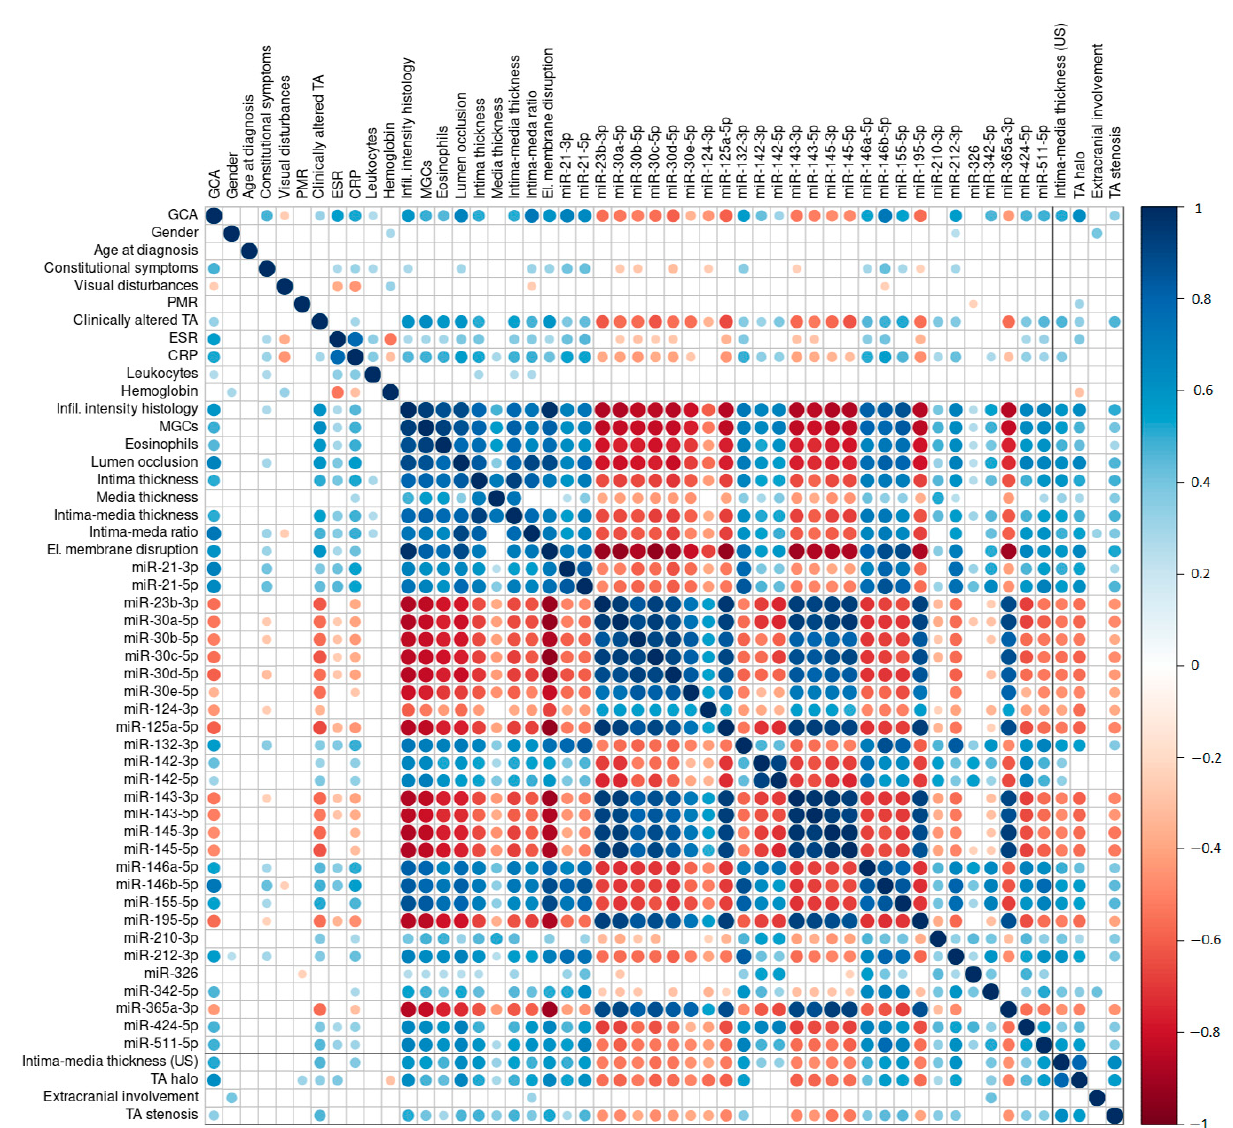
Figure 2. Correlation matrix of associations between all diagnostic parameters included in the study. Associations were calculated based on variable type combinations (nominal vs. nominal— ϕ ; nominal vs. numeric— r ; numeric vs. numeric— ρ ). Blank squares represent non-significant associations. The direction and level of corresponding correlation coefficients are presented with colors (blue for positive correlation; red for negative correlation) and their respective intensities with circle size (size of the circle increases proportionally to the correlation intensity). Associations with US examination parameters are highlighted with black